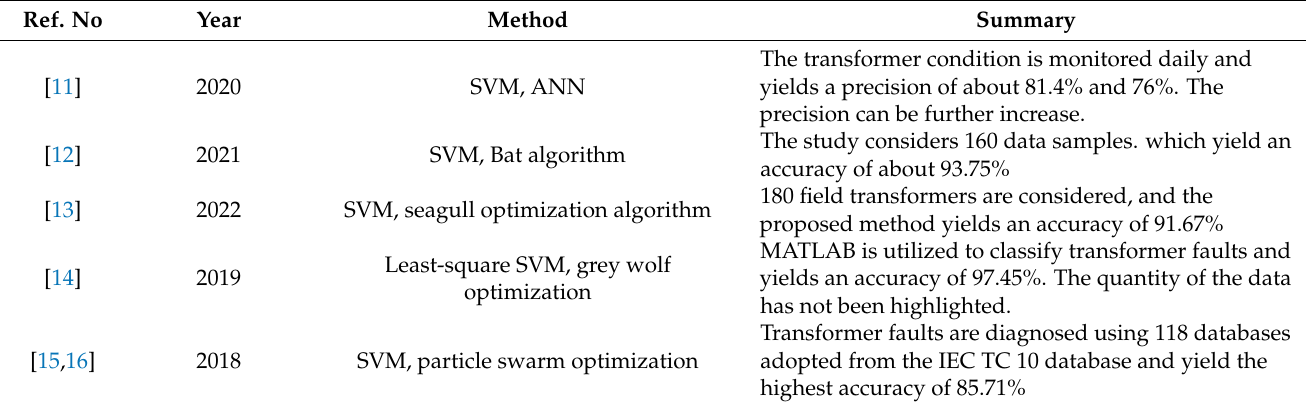
Table 1. Summary of applicable